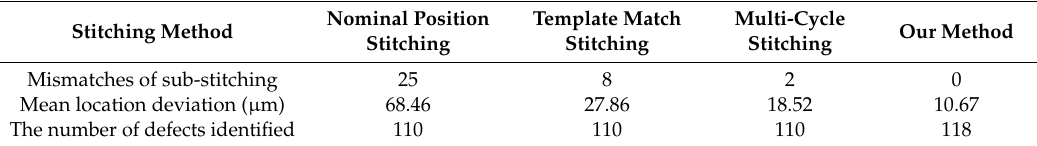
Table 1. Results